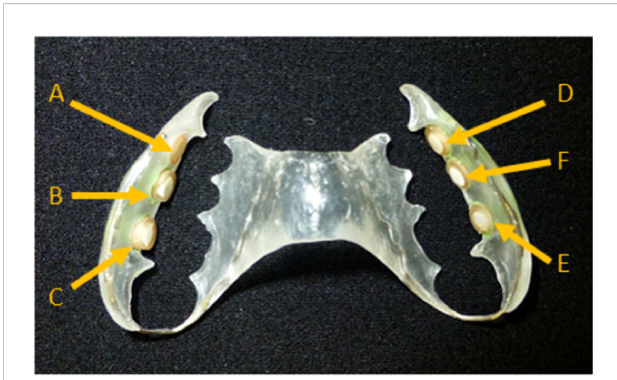
FIGURE 1 Individual acrylic splints with six enamel slabs attached to different locations. The slabs were placed in the front, in the middle and in the back on both sides, right and left. All sides of the slabs, except the enamel surface were covered with silicone and embedded in the appliance. Due to the fact that bio fi lm formation can differ from molar to premolar, the treatment groups were shifted one position further at each subject. C/E: Back; B/F: Middle; A/D: